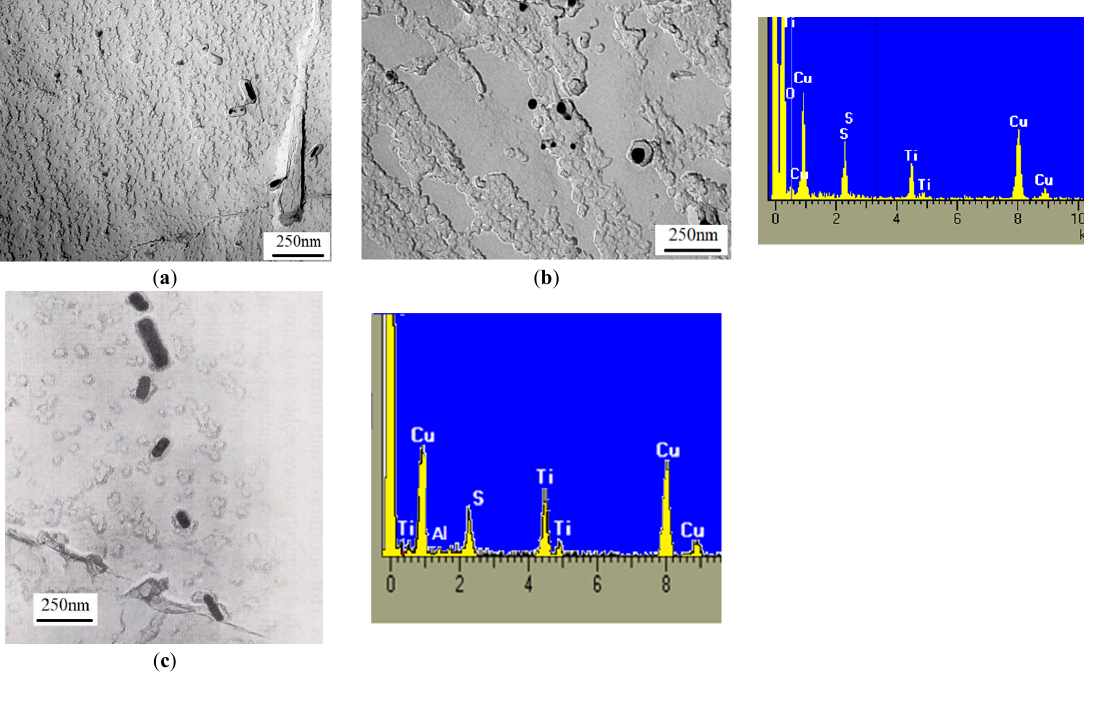
Figure 4. ( a , b ) Examples of Copper sulphide inclusions found along pre-existing austenite grain boundaries in Steel 2, hot tensile tested at 800 ◦ C in an inert atmosphere and cooled at 25 K/min with EDAX analysis. (Ti grid), ( c ) Similar steel with 0.5% Cu taken from previous work [18] tested in air but at a faster cooling rate 60 K/min showing the same precipitation, this being absent when tested in an inert